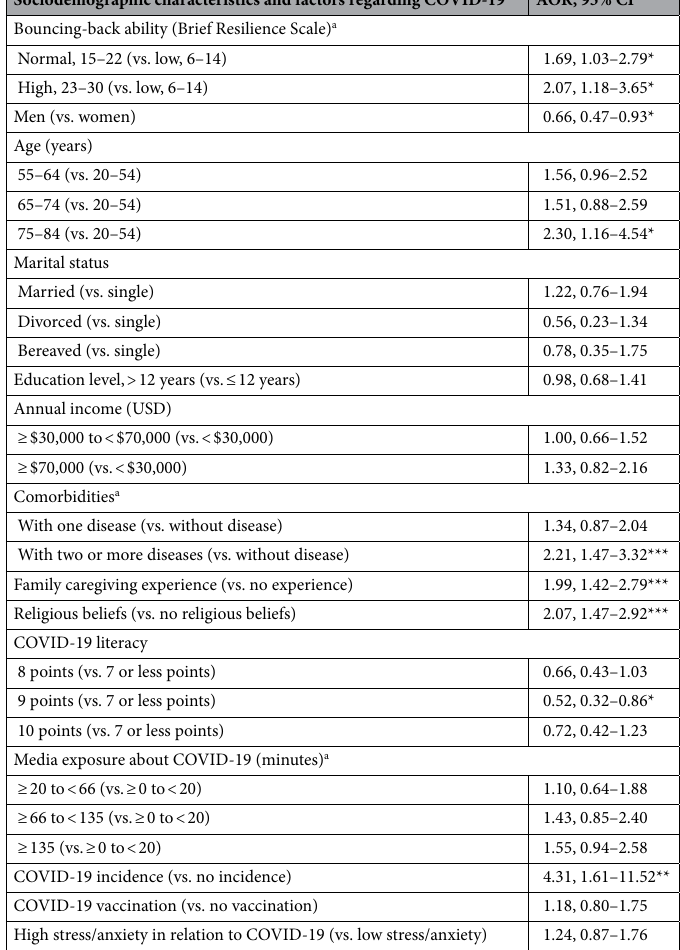
Table 2. Association between bouncing-back ability and advance care planning discussions during the COVID-19 pandemic (model 1). AOR adjusted odds ratio. * P < 0.05; ** P < 0.01; *** P < 0.001. a P for trend was <